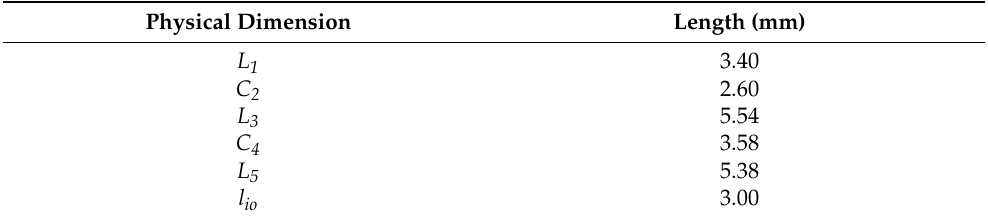
Table 5. Conventional filter dimensions. High characteristic impedance sections are w = 500 µ m wide, low impedance sections are w = 10.0 mm wide and input/output sections are w = 1.6 mm wide.